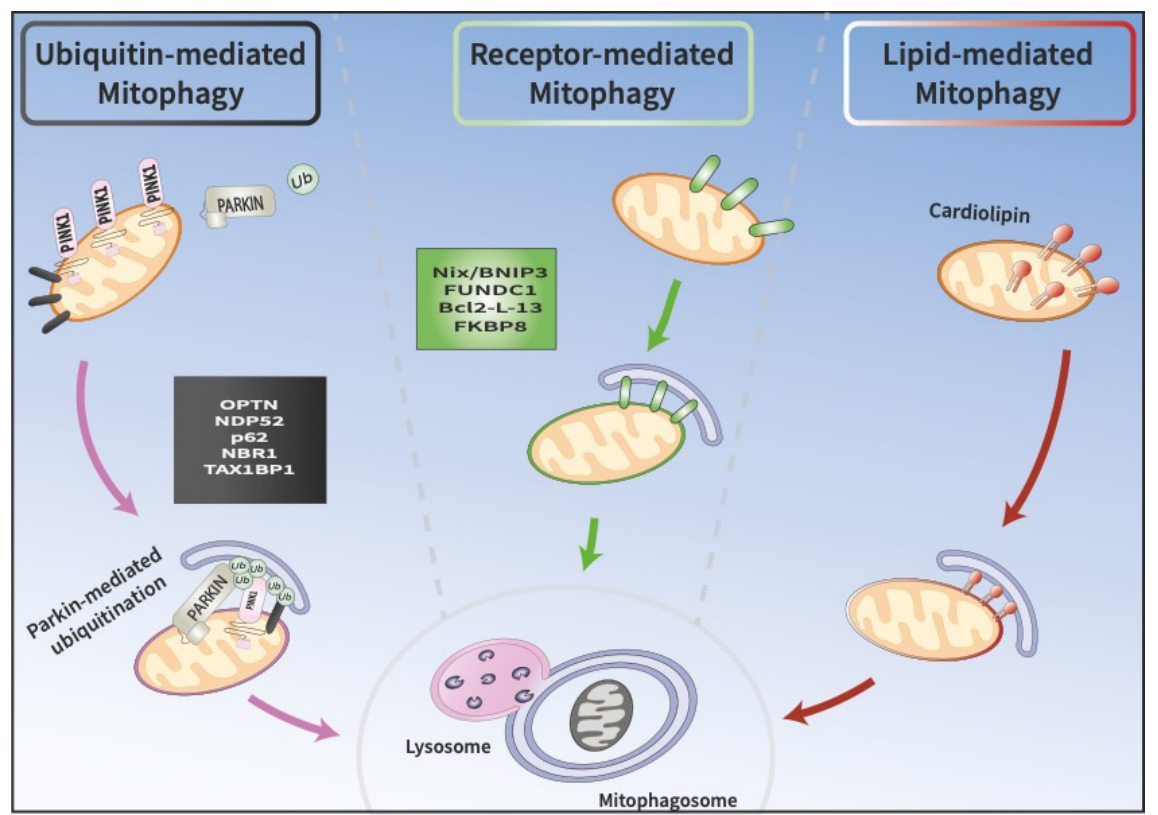
Figure 1. Three pathways at the crossroads of mitophagy. A. Ubiquitin-mediated mitophagy involves the recruitment of PINK1 and Parkin to the OMM, which promote the sequestration of damaged mitochondria into phagophores called mitophagosomes. Mitophagosomes subsequently fuse with lysosomes, where cargo is degraded. B. Receptor-mediated mitophagy depends on the direct binding of unique receptors, such as NIX/BNIP3L or FUNCD1, to LC3 on autophagosomes, which target damaged mitochondria for degradation. C. In lipid-mediated mitophagy, cardiolipin is externalized from the IMM to the OMM, where it binds to LC3 on mitophagosomes.